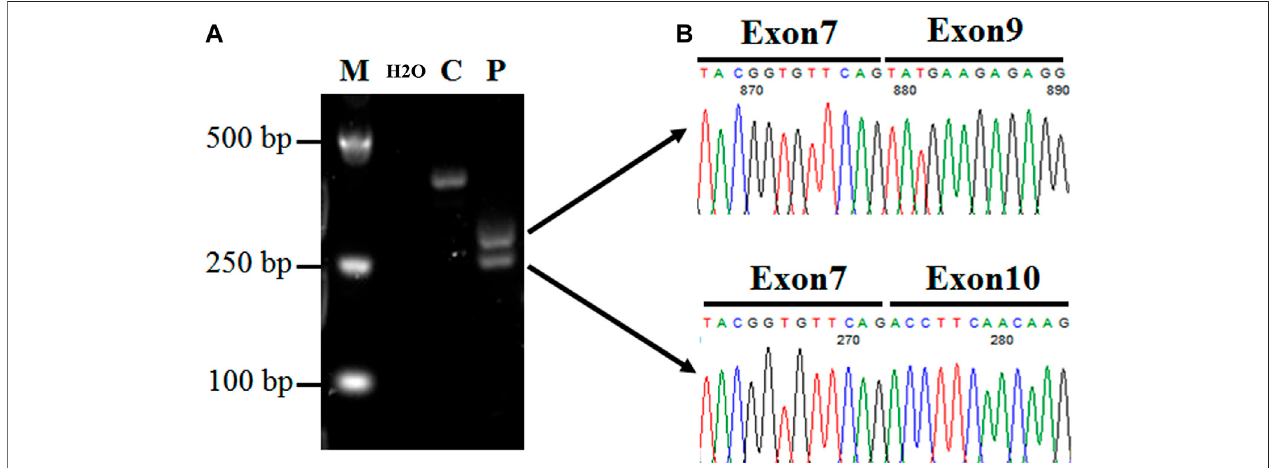
FIGURE 4 | Expression analysis of CFAP251 mRNA in spermatozoa from a normal male control and a man harboring the CFAP251 variant. (A) The RT-PCR product obtained from the proband displayed two bands obviously shorter than the normal control, suggesting two splicing alterations. (B) The TA cloning sequencing results of the two electrophoresis bands show the skipping of exon 8 and both exons 8 and 9.